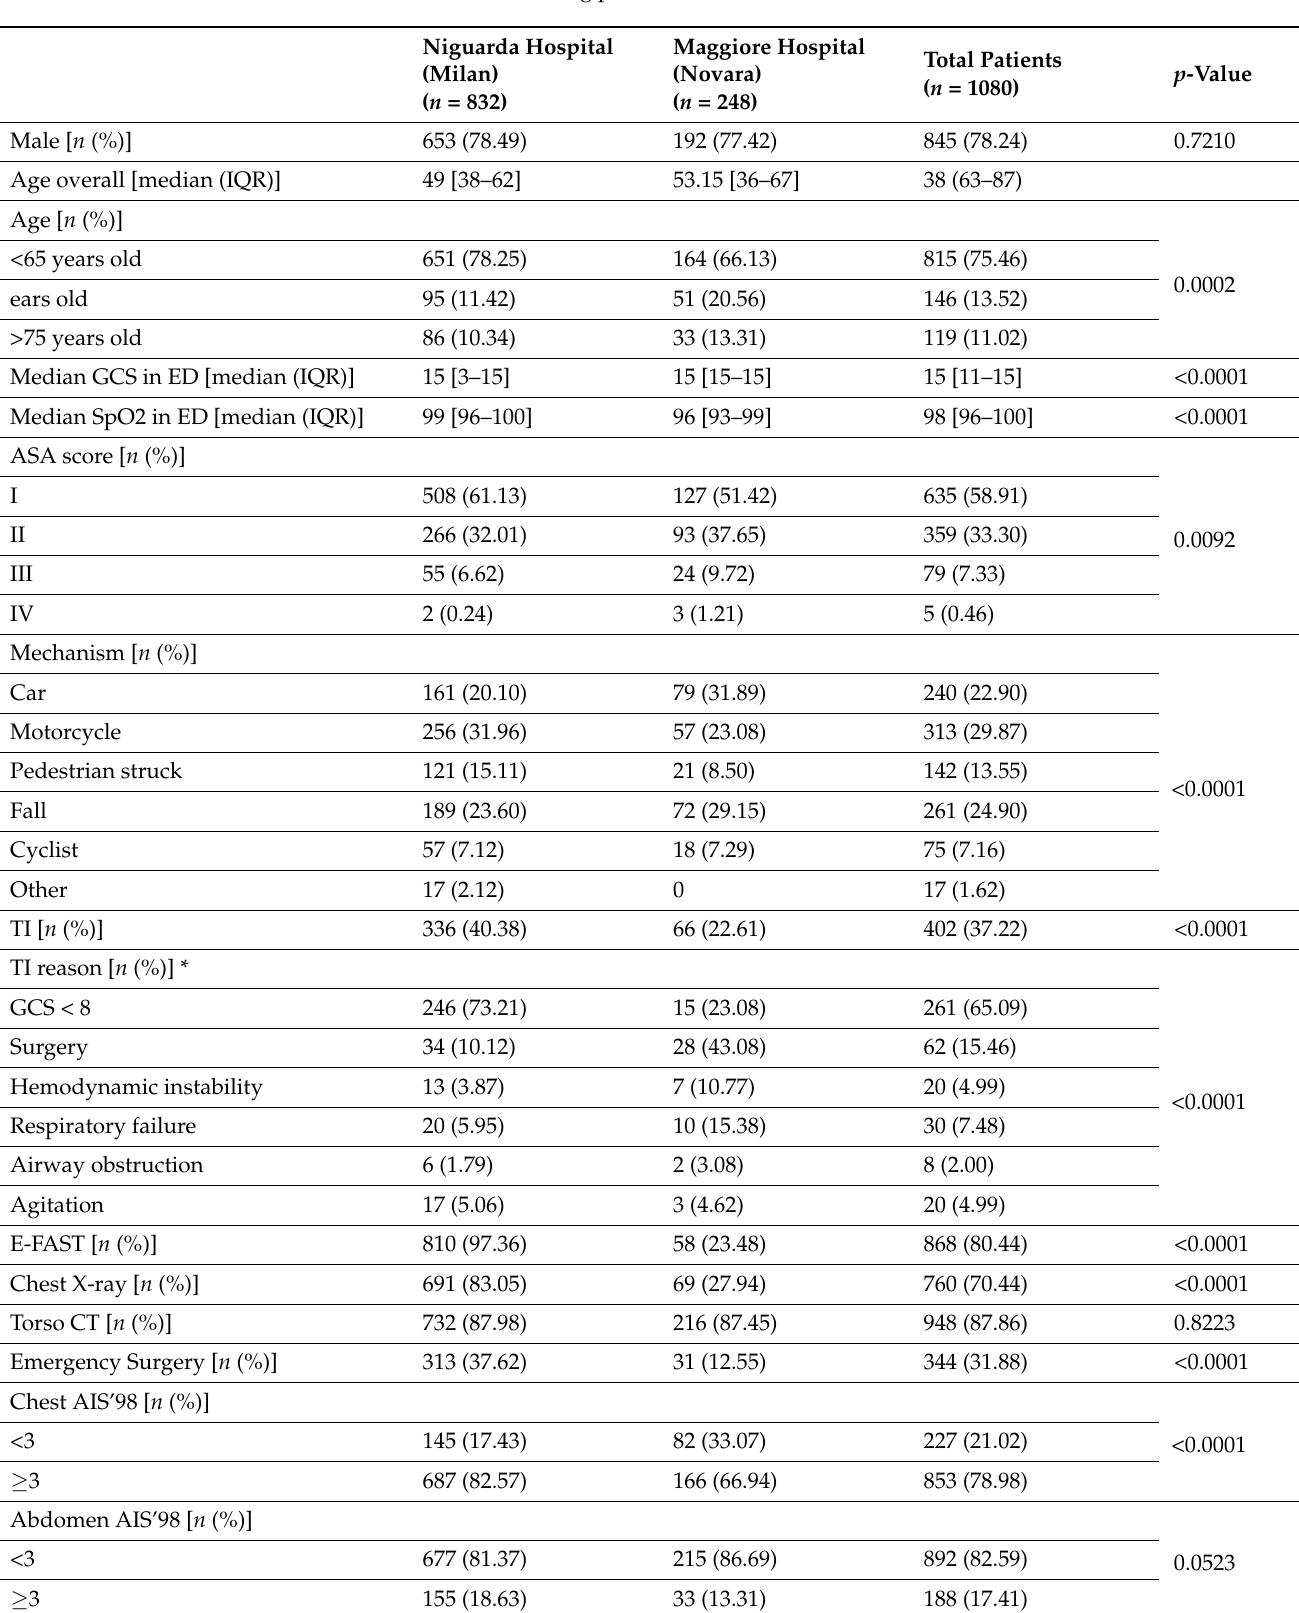
Table 1. Differences among patients treated in the two